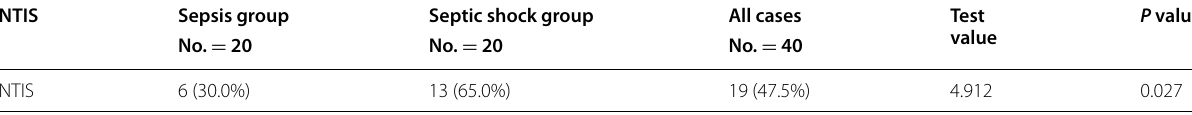
Table 2 Descriptive characteristics of studied patients regarding NTIS frequency